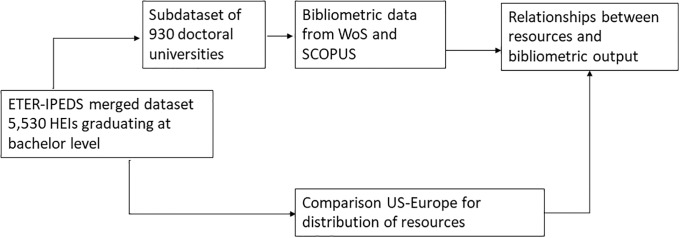
Empirical strategy.